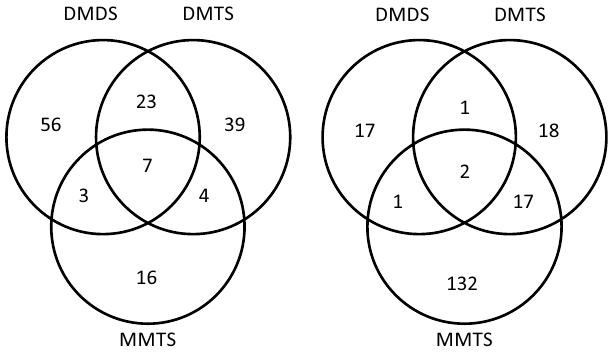
Figure 6. Overview of proteins commonly or specifically regulated by individual sVOCs. Venn diagrams depict the comparison of proteins regulated by DMDS, DMTS and/or MMTS in P. infestans . Left, UP/ON proteins; right, DOWN/OFF